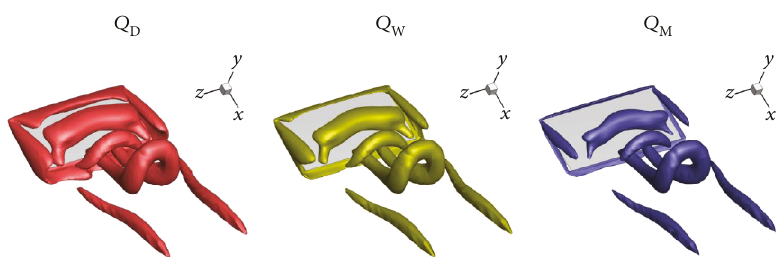
Q Q D , W , and M (isovalue 2.0).